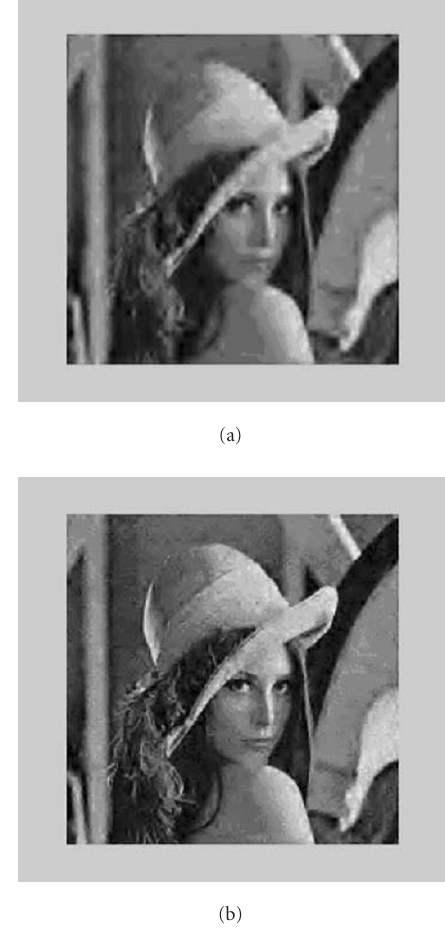
Figure 6: Denoised Lena image by approximation prefiltering: (a) decomposed with the GHM multiwavelet and thresholded with the univariate scheme; (b) decomposed with the SA4 multiwavelet and thresholded with the proposed scheme.